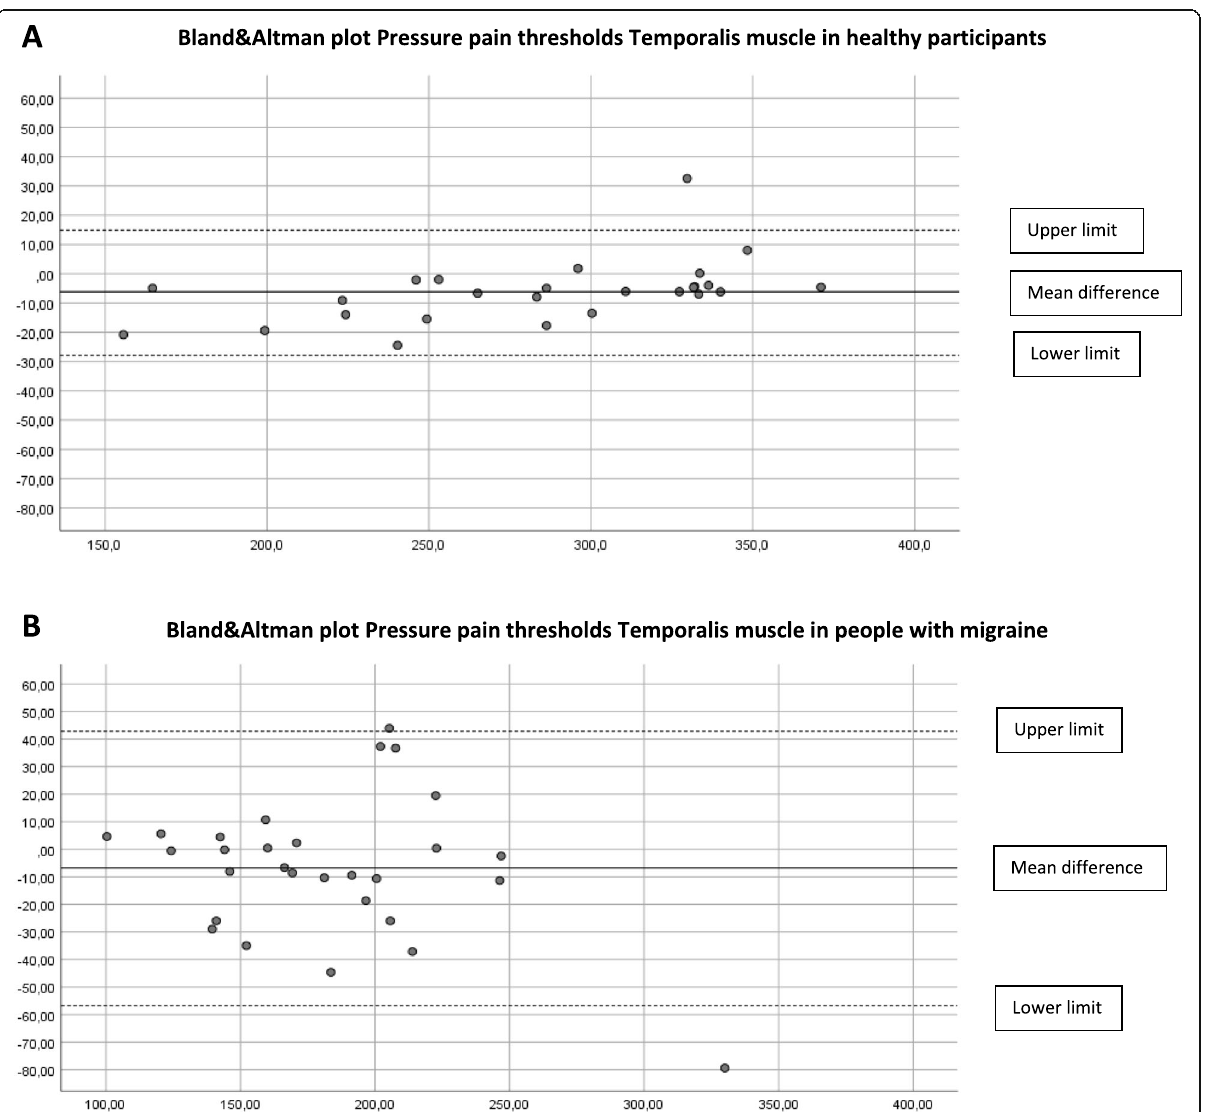
Fig. 2 A Differences Pressure Pain Thresholds digital and analogue algometer Temporalis muscle dominant side in healthy participants (mean difference, upper and lower limit). B Differences Pressure Pain Thresholds digital and analogue algometer Temporalis muscle dominant side in people with migraine (mean difference, upper and lower